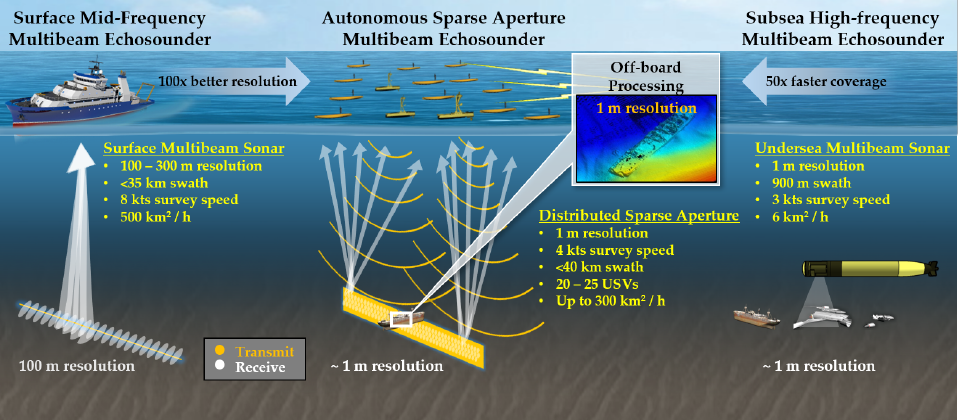
Figure 1. The autonomous sparse-aperture concept offers a potential 100-fold improvement in resolution compared with existing surface ship multibeam sonar, or a potential 50-fold increase in coverage rate compared with subsea